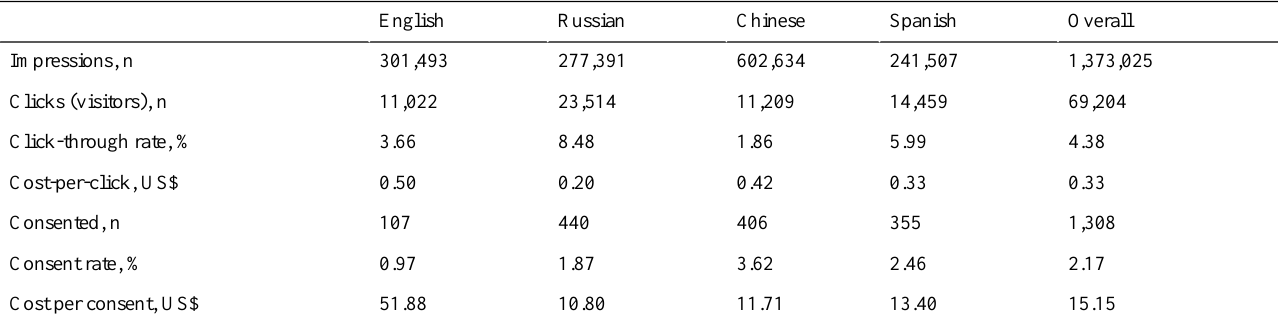
Table 1. Statistics from the unmanaged 6-month